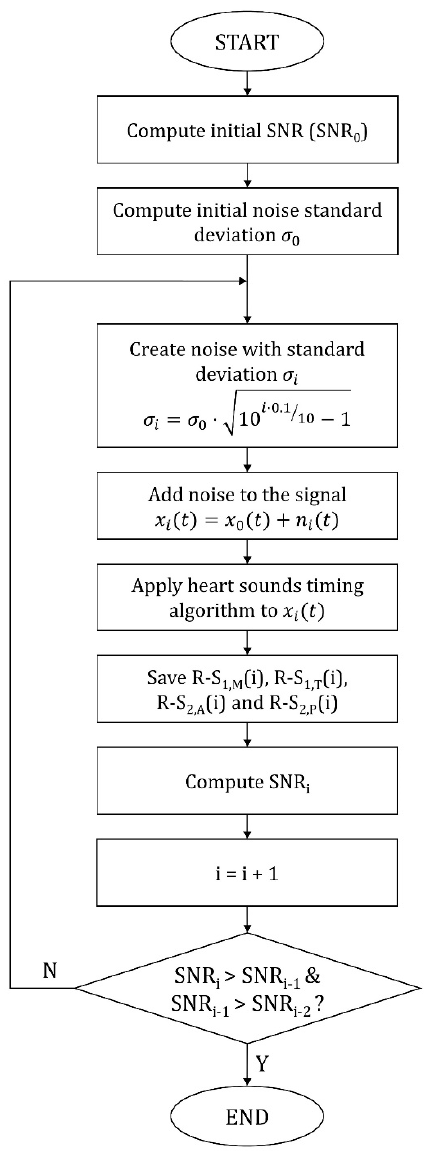
Figure 2. Flowchart of the algorithm described in this work. R-S 1,M , R-S 1,T , R-S 2,A and R-S 2,P are the latencies of the mitral, tricuspid, aortic and pulmonary valves with respect to the corresponding R-peak.